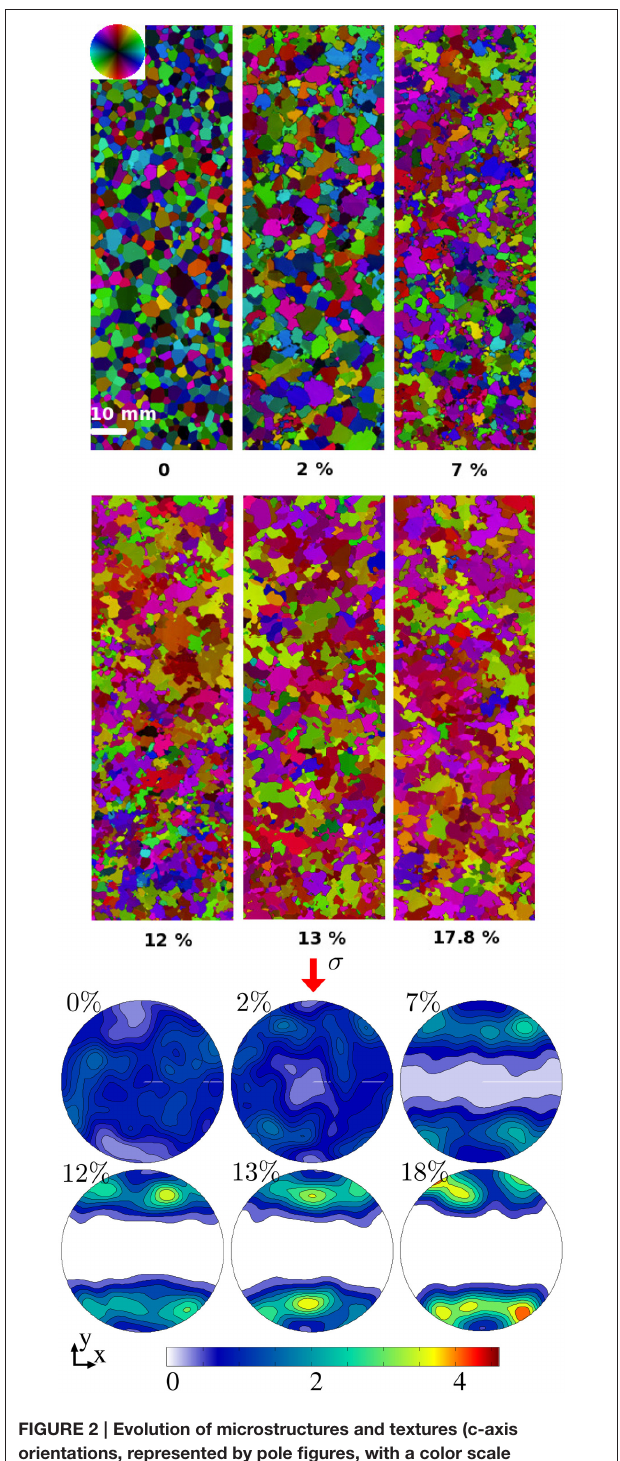
FIGURE 2 | Evolution of microstructures and textures (c-axis orientations, represented by pole figures, with a color scale corresponding to the relative number of pixels plotted) during creep tests on ice polycrystals that have been deformed to different strains (as indicated by the percentage). The direction of compression is vertical. Data are obtained from the AITA, with a c-axis orientation color-scale given by the color-wheel. The resolution is the same for all